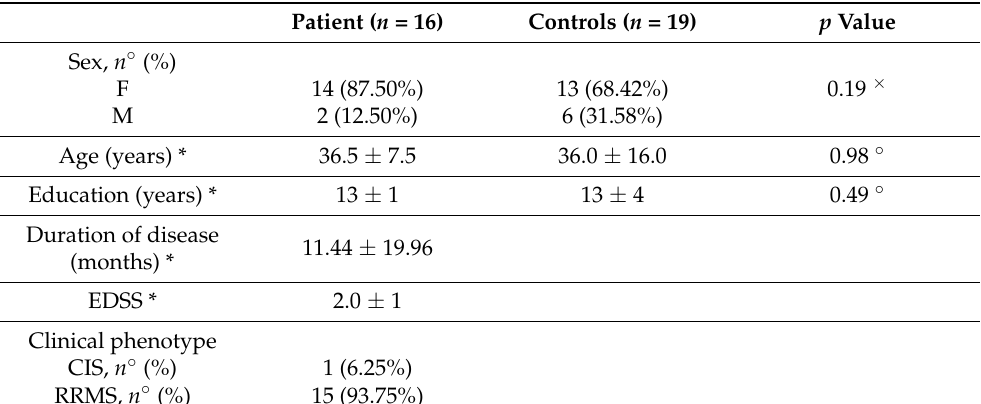
Table 1. Demographic and clinical variables of participant